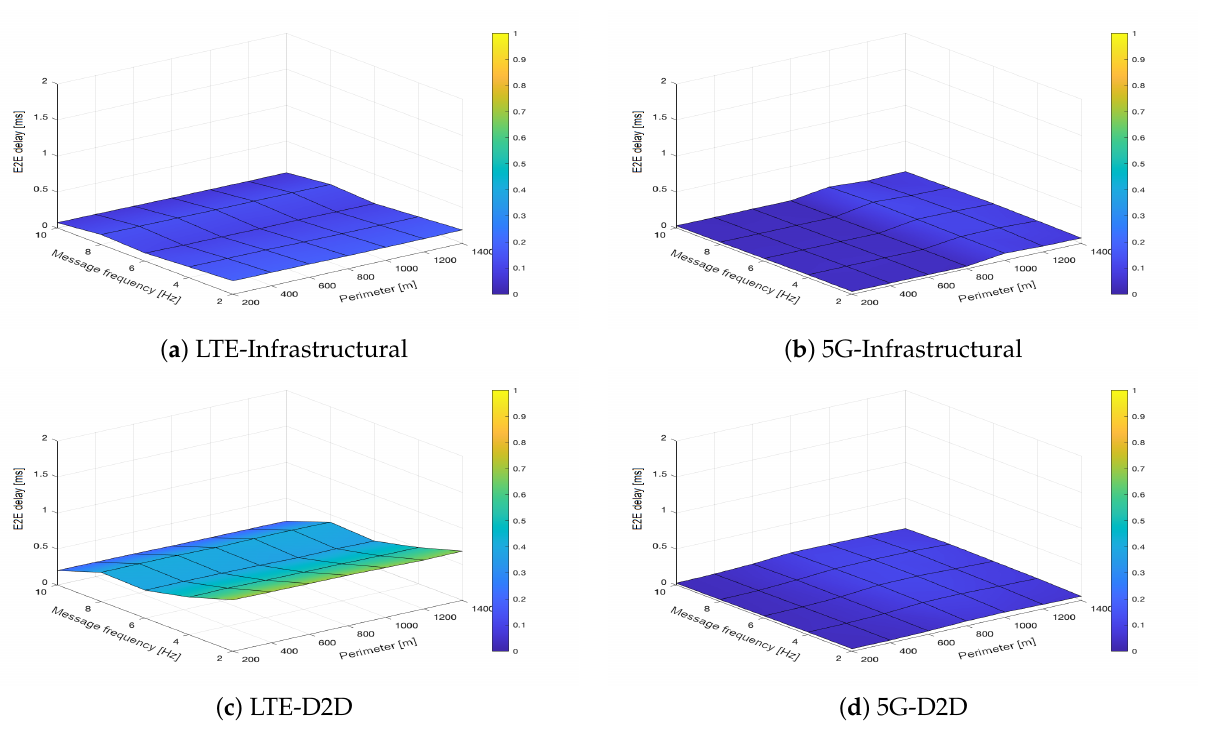
Figure 11. E2E latency simulated for all the investigated modes of the 4G-based and 5G-based C-V2X technologies and traffic intensity of 1000 vehicles per hour.